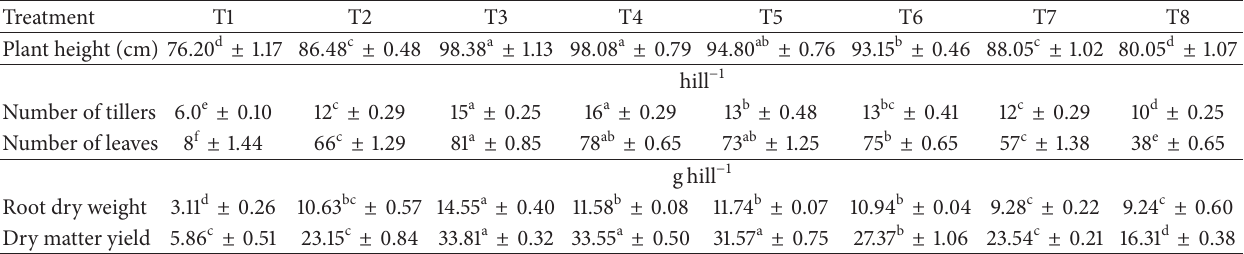
Table 7: Effects of biochar and nitrogen fertilization on measured variables of rice plants in the pot study. Treatment T1